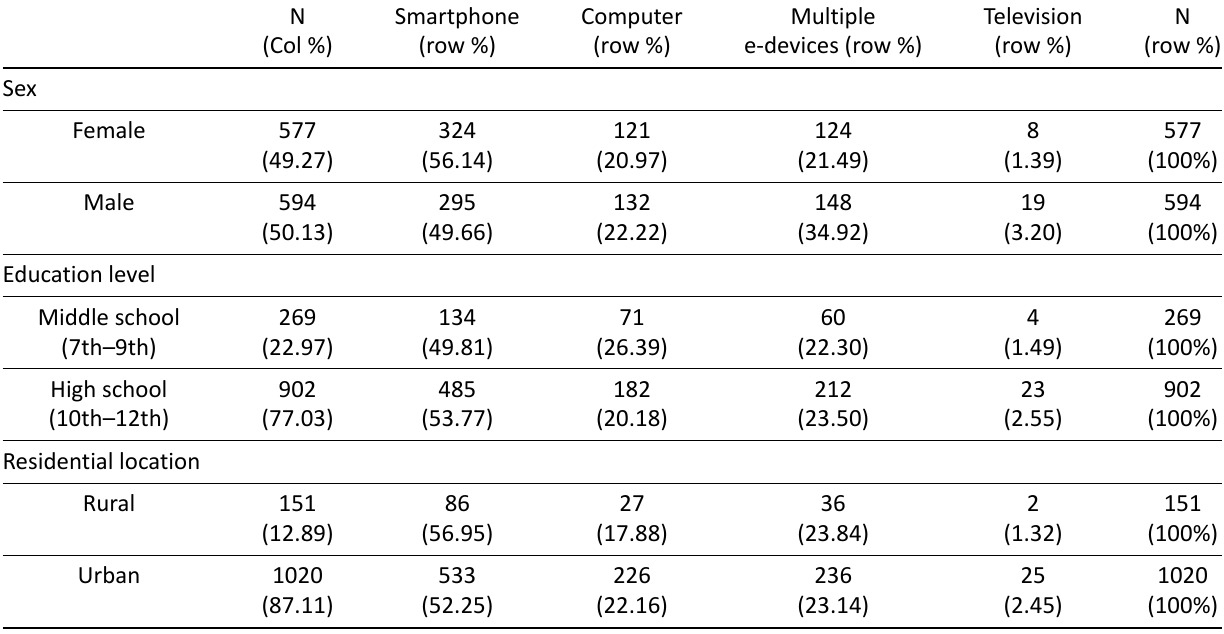
Table 2. Descriptive statistics and bivariate analysis results (N =